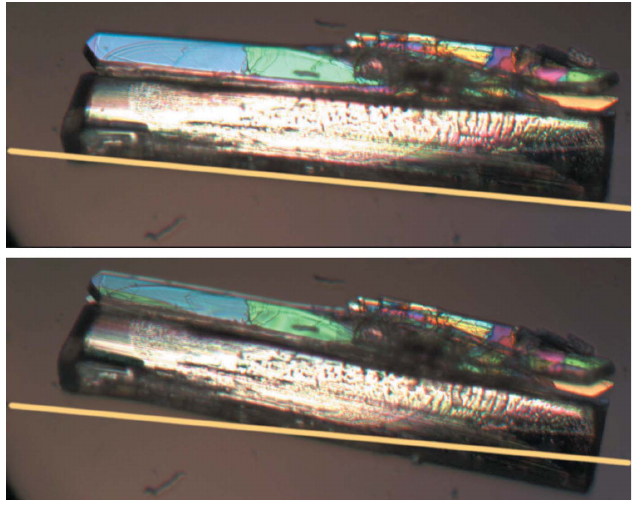
Figure 13 Thermal stage measurements of the (cid:2) ! (cid:3) transition of dl -Nle. The crystal shows some rapid angular displacement (a line has been added as a